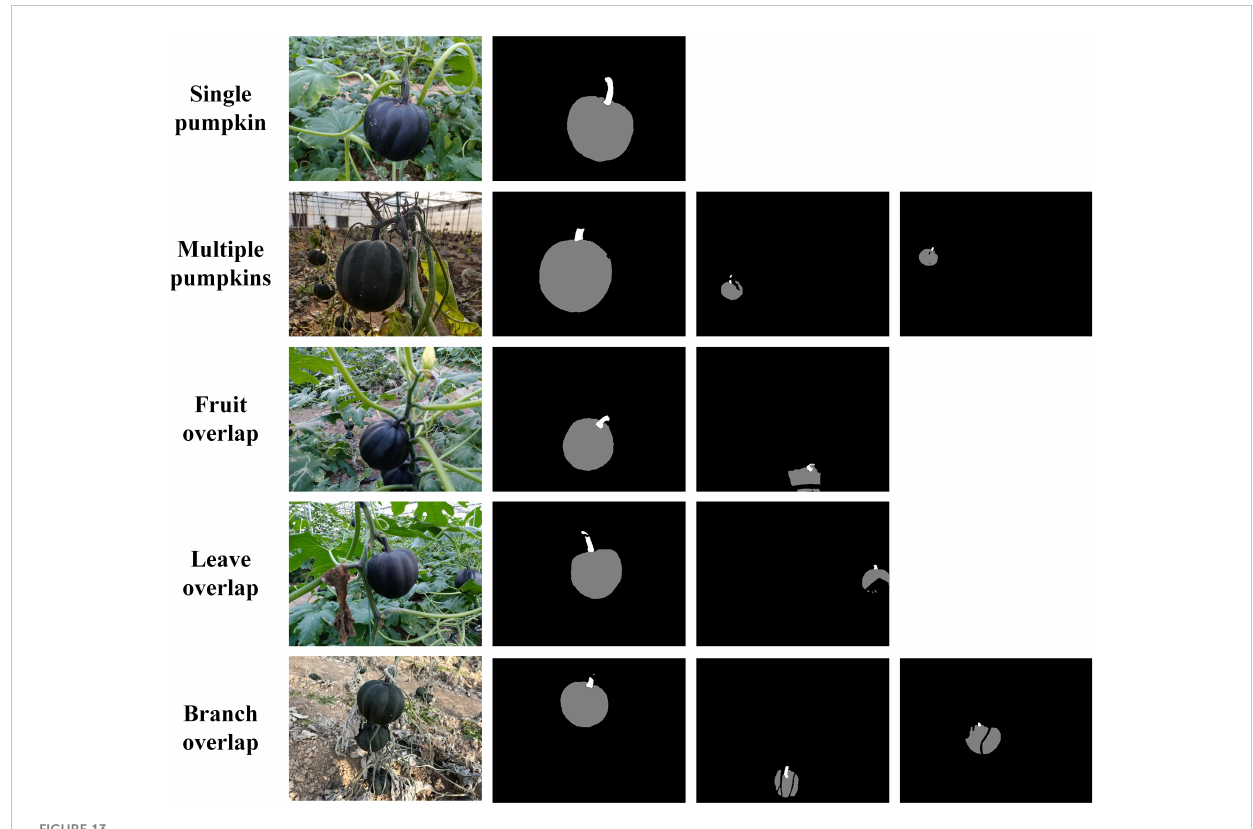
FIGURE 13 Pumpkin fruit and stem matching